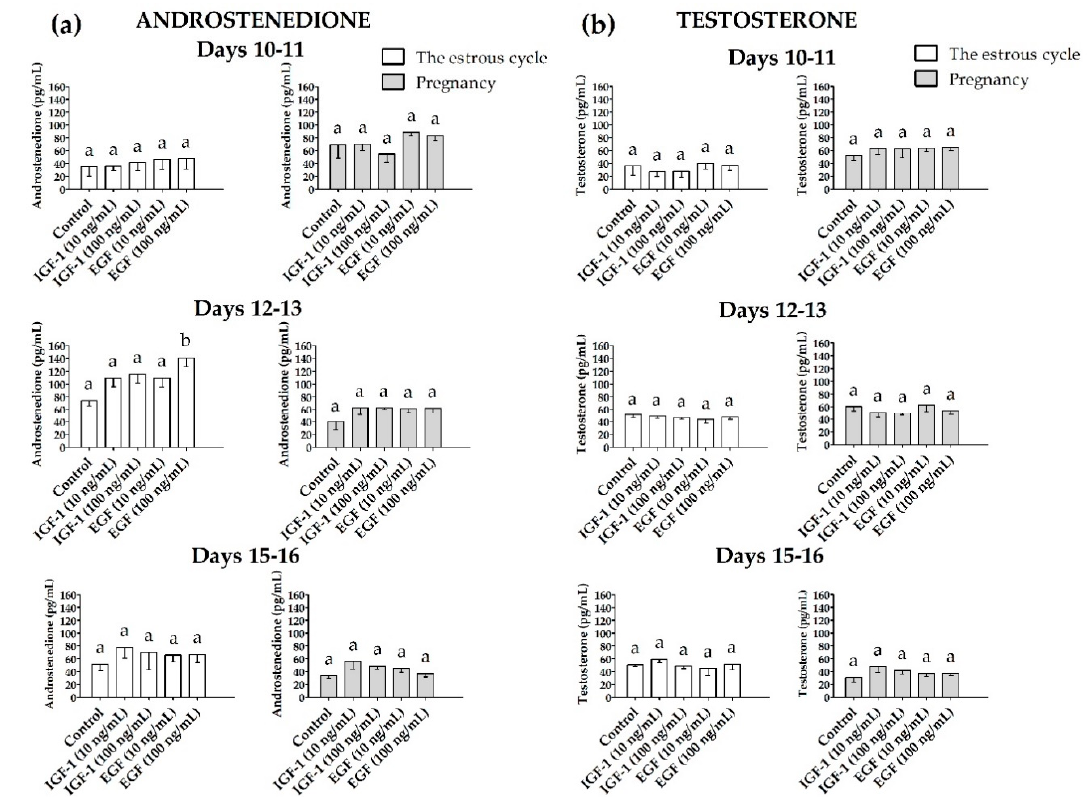
Figure 6. The concentration of ( a ) androstenedione and ( b ) testosterone in media collected after in vitro incubation of myometrial slices treated with IGF-1 (10 and 100 ng / mL) or EGF (10 and 100 ng / mL, one-way ANOVA, Dunnett’s post hoc test). Statistically significant differences were considered at p ≤ 0.05 and indicated as lower-case letters (a,b) above the bars.